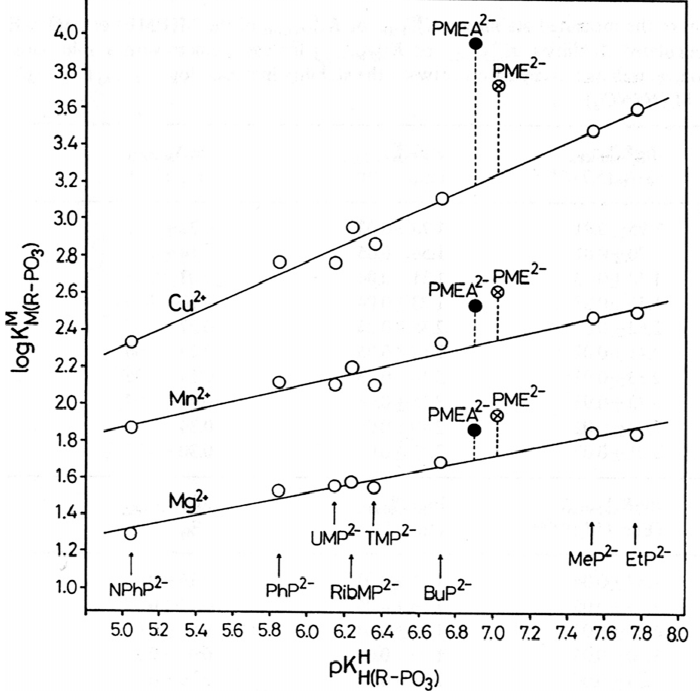
Figure 4. Evidence for enhanced stabilities of some M(PMEA) ( • ) complexes in comparison with those of the corresponding M(PME) ( ⊗ ) species, based on the relationship between log K M M ( R − PO 3 ) and p K H for M(R-PO 3 ) complexes of some simple phosphate monoester and phosphonate ligands (R-PO 32– ) ( ◯ ): 4-nitrophenyl phosphate (NPhP 2 − ), phenyl phosphate (PhP 2 − ), uridine 5 ′ -monophosphate (UMP 2 − ), D -ribose 5-monophosphate (RibMP 2 − ), thymidine [= 1-(2 ′ -deoxy- β - D -ribofuranosyl)thymine] 5 ′ -monophosphate (TMP 2 − ), n -butyl phosphate (BuP 2 − ), methanephosphonate (MeP 2 − ), and ethanephosphonate (EtP 2 − ) (from left to right). The least squares lines (Equation (3)) are drawn through the corresponding 8 data sets ( ◯ ) taken from Ref [48] for the phosphate monoesters and from Ref [44] for the phosphonates. The data due to the M 2+ /PMEA ( • ) and the M 2+ /PME ( ⊗ ) systems are from Ref [44]. The vertical broken lines emphasize the stability differences to the reference lines; they equal log Δ as defined in Equation (12) for the M(PME) complexes (for the M(PMEA) complexes the analogous formulation holds). All the plotted equilibrium constants refer to aqueous solutions at 25 °C and I = 0.1 M (NaNO 3 ). Reproduced with permission from our publication in Coordination Chemistry Reviews [45]; copyright 1995, Elsevier Science S.A., Lausanne, Switzerland.